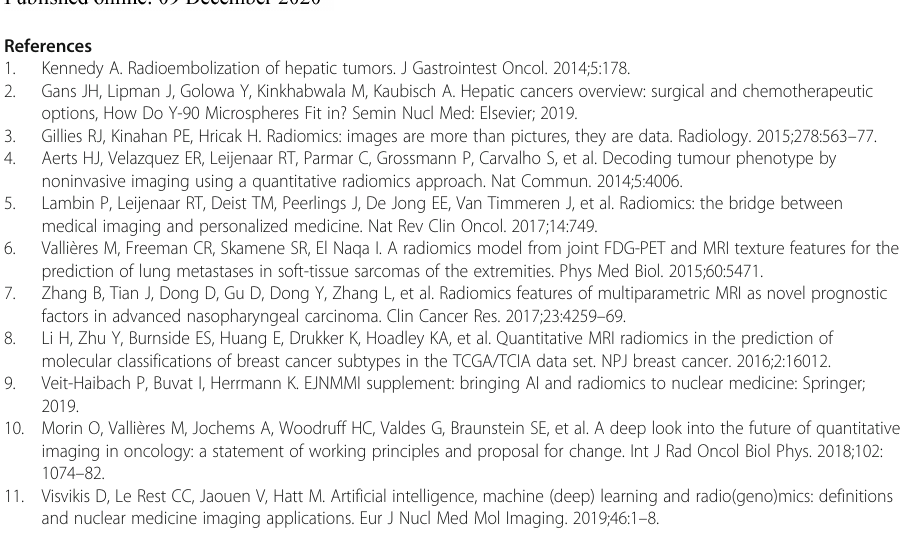
regression with c-index, hazard ratio and corresponding p-values for progression are also indicated. Supplemental Table 3. Mean CCC for 5 repeat scans of the liver phantom, OS-EM iterations 1/2, with/without Gaussian filtering and across all conditions. Supplemental Fig. 1 Radiomics_all+dose model order determination for OR (left) and PFS (right). Average AUC/c-index vs. number of top features included. When using all the radiomics features, the aver- age model order calculated using nested cross validation is 2 for OR classification and 3 for PFS, with top 2 features being variance and absorbed dose and top 3 features being variance, absorbed dose and LRHGE, respectively. The nested CV AUCs for radiomics_all+dose is 0.672 (0.620-0.716) for OR and 0.791 (95%CI: 0.740-0.825) for progression. The top 5 features are shown in supplemental table 4 for OR and progression models. Supplemental Table 4. Top 5 features for the combined models with all radiomics features, volume and absorbed